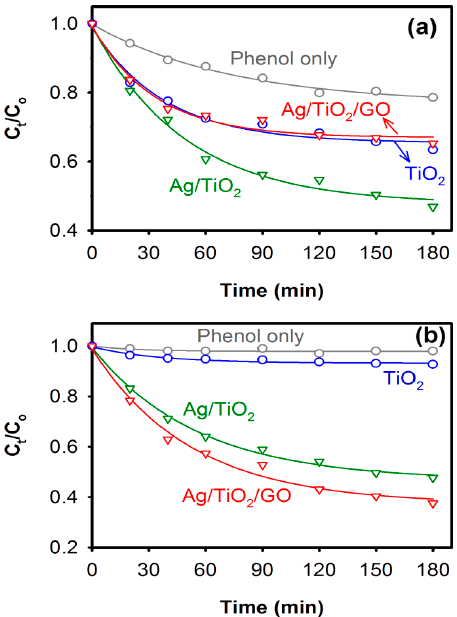
Figure 5. Photocatalytic degradation of 10 ppm phenol in aqueous solution under ( a ) UV and ( b ) visible light irradiation when TiO 2 , Ag/TiO 2 , and Ag/TiO 2 /GO nanocomposites were used as photocatalysts.